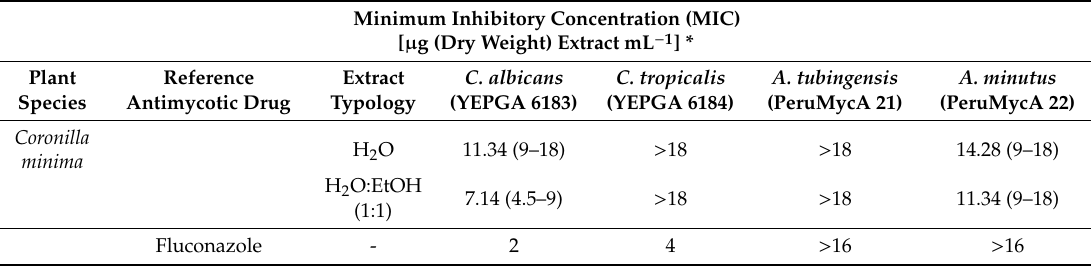
Table 4. Minimum inhibitory concentration (MIC) of plant extract toward selected yeasts and filamentous fungal